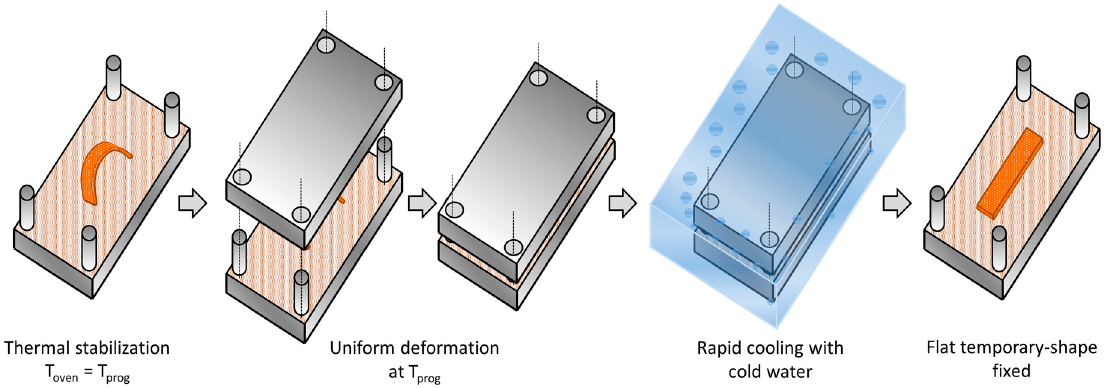
Figure 3. Illustration of the shape-memory programming process.